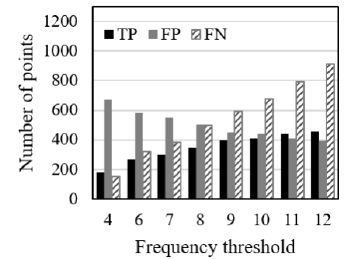
Figure 4. Effect of frequency threshold (isolated) on SF filter, using a voxel size (step) of 2 m